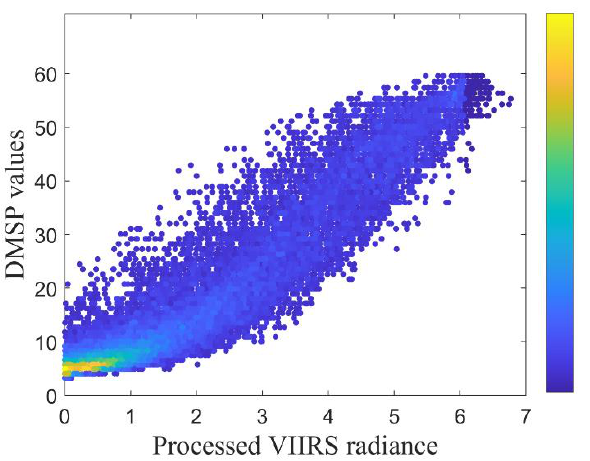
Figure 2. Scatter density plots of DMSP and processed VIIRS nighttime lights (NTLs) in 2013.